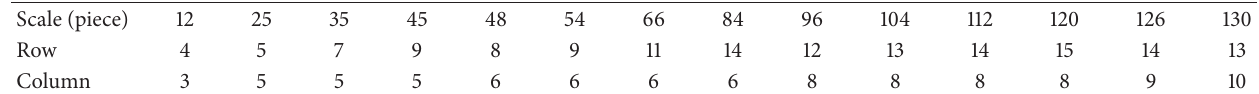
Figure 12: The interrow space. Table 1: The fragment scale of the shredded